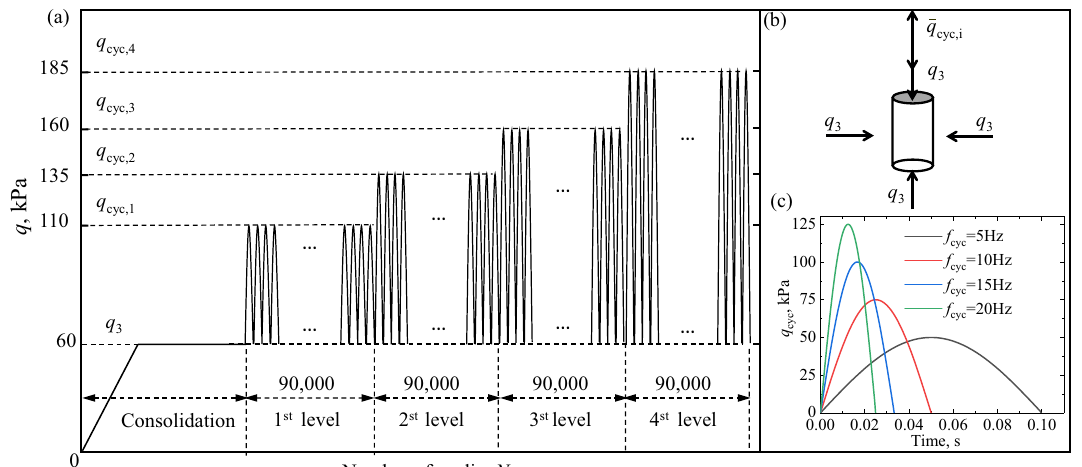
Figure 3. Loading patterns: ( a ) focusing on q cyc , ( b ) schematic diagram of stress path on sample and ( c ) focusing on f cyc .